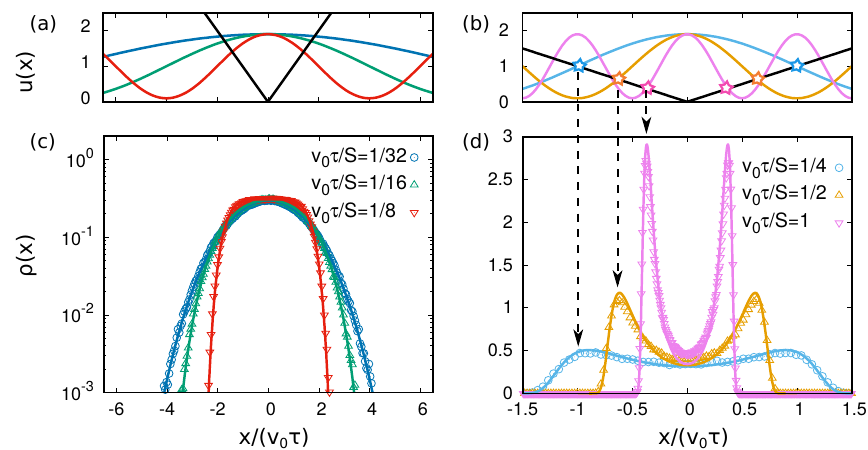
Figure 1: Density distributions. Panels (a) and (b): swim-velocity profile u ( x ) for different values of S (colored curves), compared with the modulus of the linear force profile, | F ( x ) | = − k | x | /γ (black curve) as a reference. The colored stars are placed at the first cross point between u ( x ) and F ( x ) /γ . Panels (c) and (d): spatial density profile, ρ ( x ) , for different values of S . Points are obtained by numerical simulations while solid lines by plotting the theoretical prediction (10) (that reduces to Eq. (16) in one dimension with Λ ( x ) given by Eq. (19)). The integral occurring in Eq. (16) has been performed numerically. Panels (a), (c) and (b), (d) share the same legend. Simulations are realized in one spatial dimension with τ k /γ = 1 and α =